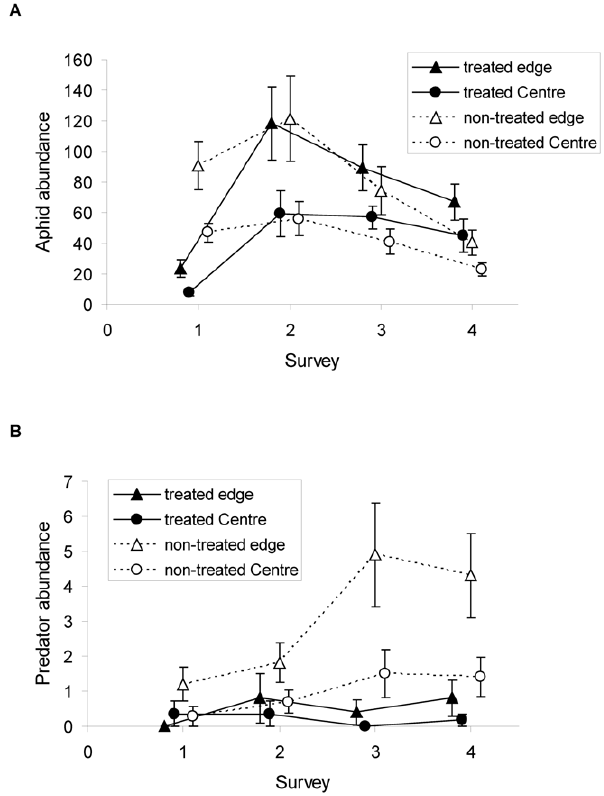
Figure 5. Temporal dynamics of (a) aphid abundance and (b) predator abundance in insecticide treated and non-treated conventional triticale field edges and centres (mean ± se). Statistics see Table